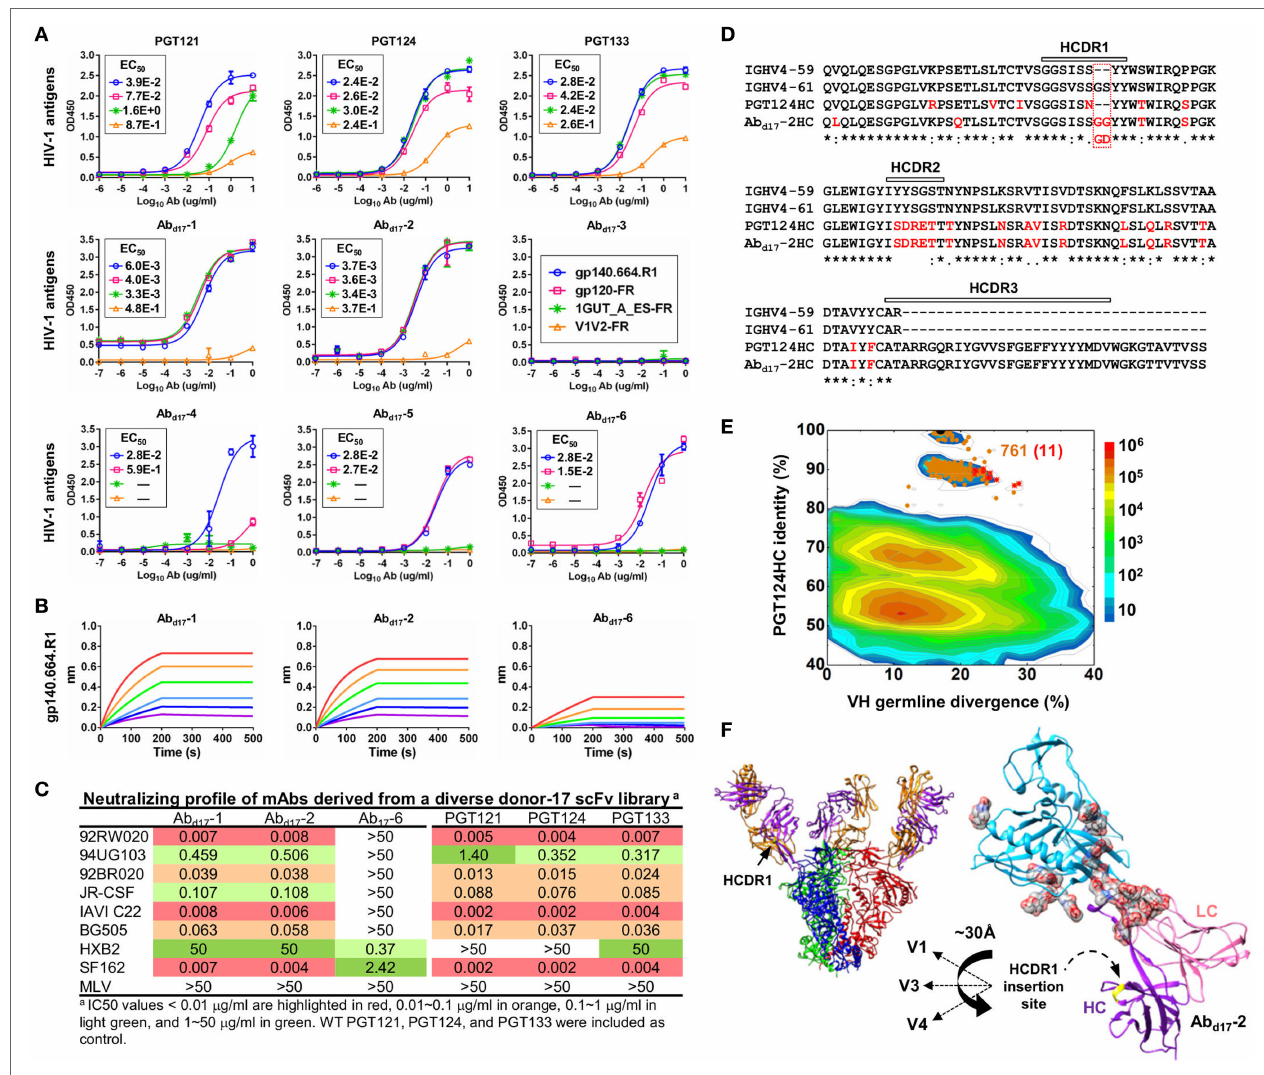
FigUre 4 | Characterization of monoclonal antibodies (mAbs) identified from a diverse donor-17 single-chain variable fragment (scFv) library. (a) Enzyme-linked immunosorbent assay (ELISA) binding of three broadly neutralizing antibodies (bNAbs) of the PGT121 class (PGT121, 124, and 133) and six scFv-derived mAbs, Ab d17 -1–6, to four HIV-1 antigens including a native-like trimer (gp140.664.R1), a gp120 nanoparticle (gp120-FR), a nanoparticle presenting 24 copies of the scaffolded N332 supersite (1GUT_A_ES-FR), and a clade-C V1V2 nanoparticle (V1V2-FR). EC 50 values are labeled for all ELISA plots except for instances in which the highest OD 450 value is below 0.1 or in the cases of ambiguous data fitting. (B) Octet binding of Ab d17 -1, -2, and -6 to the native-like trimer gp140.664.R1. Sensorgrams were obtained from an Octet RED96 instrument using a titration series of six concentrations (200–6.25 nM by twofold dilution). (c) Neutralization profiles of Ab d17 -1, -2, and -6 against six tier-2 viruses and two tier-1 viruses, with WT bNAbs PGT121, 124, and 133 included as references. IC 50 values are highlighted based on the following color-coding scheme: < 0.01 µg/ml (red), 0.01–0.1 µg/ml (orange), 0.1–1 µg/ml (light green), and 1–50 µg/ml (green). (D) Sequence alignment of Ab d17 -2 with two HC germline genes (IgHV4-59 and IgHV4-61) and PGT124 HC. The three HCDR regions are marked above the sequences, with the mutations with respect to IgHV4-59 colored in red. (e) Identity-divergence analysis of the HC repertoire obtained from S5 sequencing. Sequences are plotted as a function of sequence identity to PGT124 HC and sequence divergence from germline genes. Color-coding indicates sequence density at a particular point on the 2D plot. PGT124 HC is labeled on the 2D plot as a black dot. Sequences with HCDR3 identity of 95% or greater to PGT124 are shown as orange dots on the 2D plots, with the ones containing a 2-aa heavy chain complementarity-determining region 1 (HCDR1) insertion shown as red asterisks. (F) Structural models of Ab d17 -2 in complex with a native-like trimer (gp140.664.R1) and engineered gp120 outer domain (eOD). The Ab d17 -2:gp140 complex was modeled upon two trimer structures (PDB IDs: 5JS9 and 5T3S), while the Ab d17 -2:eOD complex was modeled upon the PGT124:eOD complex (PDB ID: 4R2G). While the proteins are shown as ribbons in both cases, the molecular surface is also shown for glycans in the latter case. The distance (~30 Å) between the Ab d17 -2 HCDR1 and three gp120 glycan-rich loops is